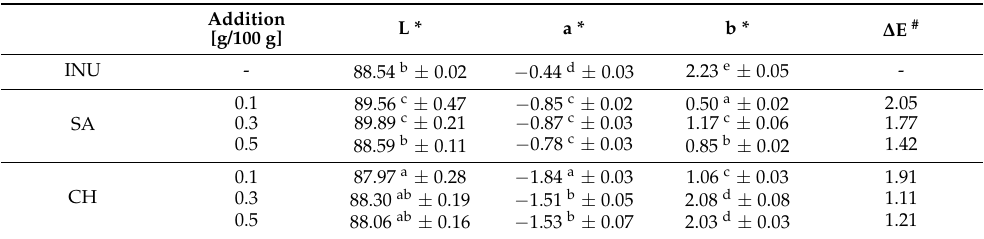
Table 2. Effects of sodium alginate (SA) and chitosan (CH) addition on the color parameters of inulin hydrogels and the total color difference ( ∆